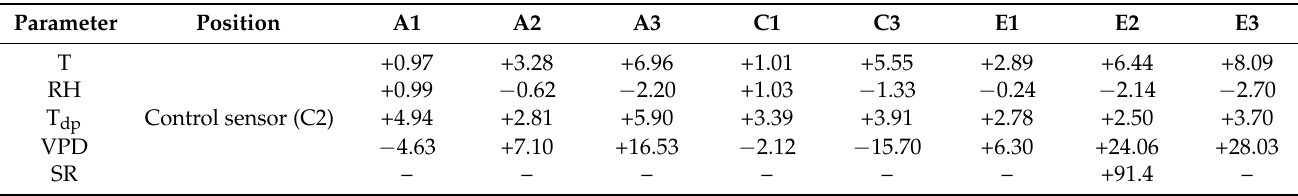
Table 6. Percentage change in parameter sum between control sensor and other sensors in DLG (double-layered greenhouse). T: air temperature; RH: relative humidity; T dp : dew point temperature; VPD: vapor pressure deficit; SR: solar radiation.